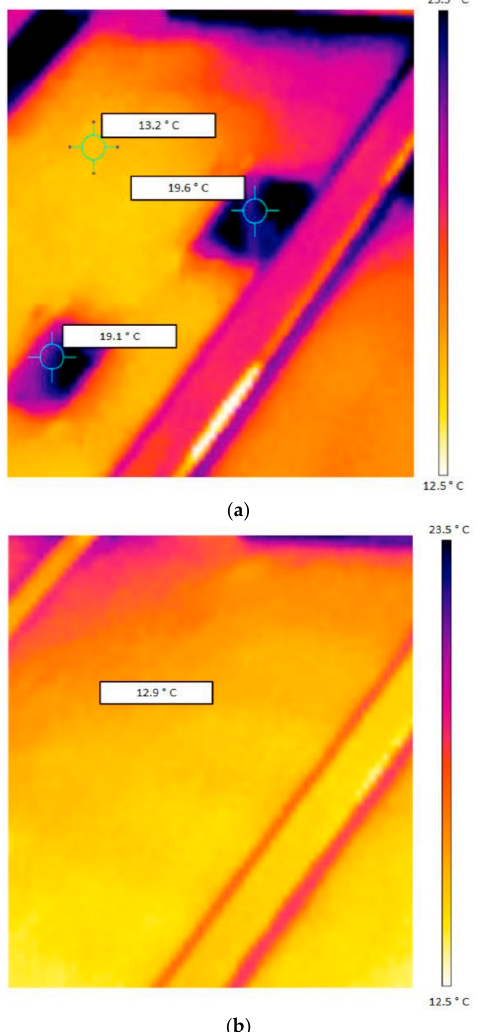
Figure 13. Impact of proposed mitigation technique on hotspots of the PV module, that are present due to partial shading. ( a ) Thermal image of PV module before using technique ( b ) Thermal image after using technique [86]